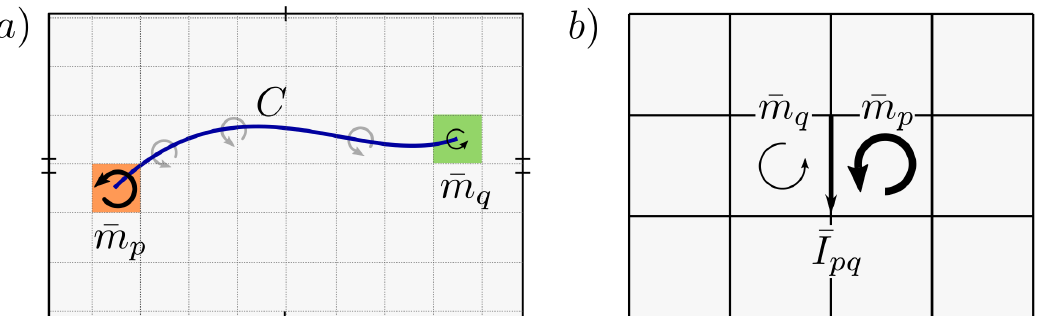
Figure 2: a) Schematic depiction of the relationship between current and magneti- zation density [ Eq. (4) ] . In many-body localized systems, the time-averaged current passing through a cut C is determined by the difference between the currents cir- culating around the cut’s two end-points, p and q . The currents circulating around plaquette p are measured by the magnetization density operator ¯ m . b) Ampere’s p law on the lattice. The difference in magnetization densities between two adjacent plaquettes p and q gives the current ¯ I on the bond between pq